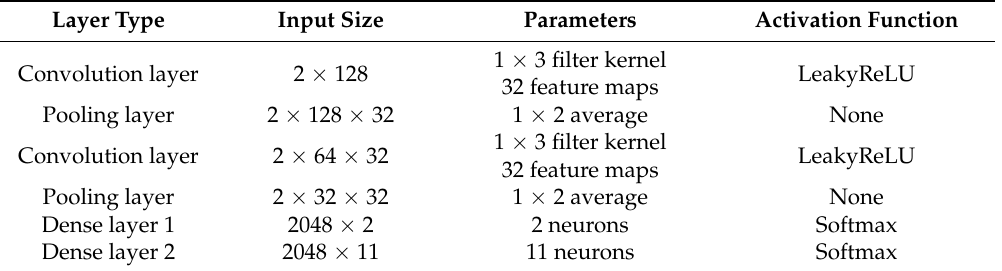
Table 1. Proposed discriminator and classifier